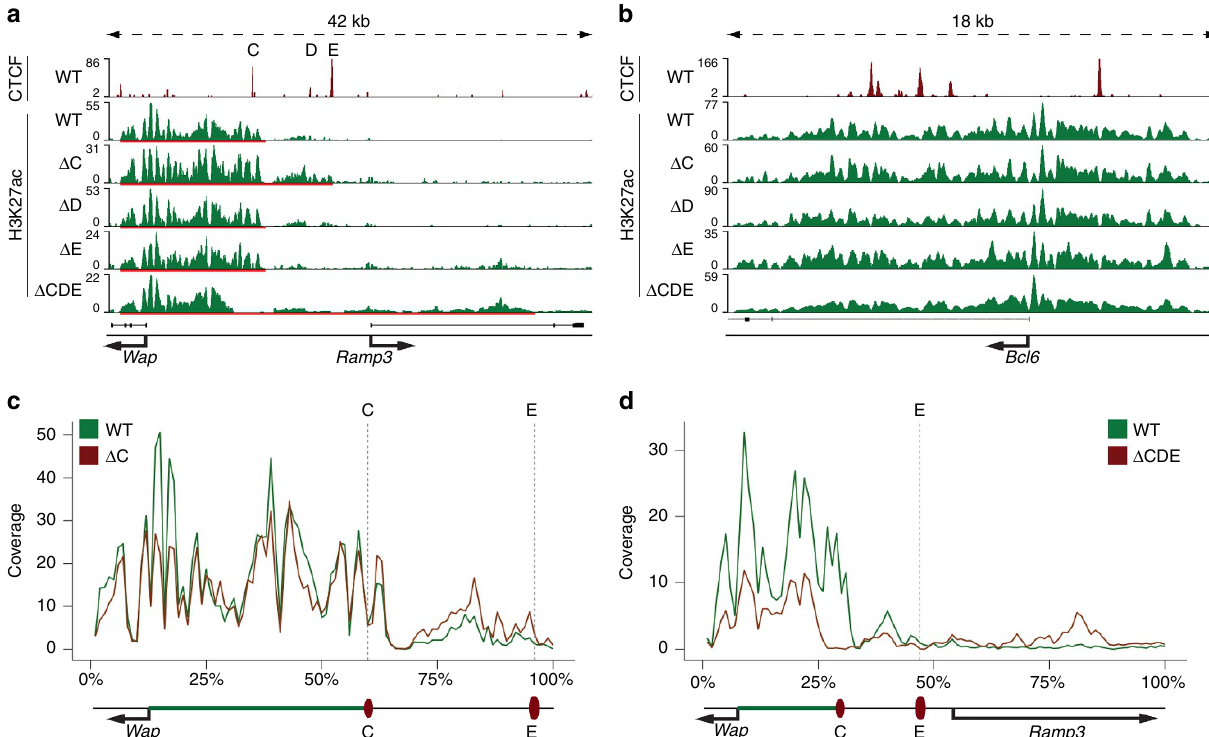
Figure 5 | Expansion of H3K27ac marks upon deletion of CTCF sites. ChIP-seq was used to identify changes of H3K27ac due to mutated CTCF-binding sites. ( a ) Deletion of CTCF site C resulted in the expansion of H3K27ac associated with the Wap super-enhancer (red bar). This was not observed upon loss of sites D or E. The combined loss of sites C, D and E resulted also in an expansion of H3K27ac and was particular strong at a specific site in the first intron of Ramp3 (normalized to 10 million reads) (red bar). ( b ) H3K27ac intensity was equivalent in the unrelated Bcl6 locus. ( c ) H3K27ac profiles of the Wap-Ramp3 locus based on the data shown in a . Green, WT pattern; red, D C. The degree of H3K27ac in mutants was elevated between CTCF sites C and E confirming the expansion of H3K27ac (normalized to 10 million reads). ( d ) H3K27ac profiles of the data shown in a . WT is shown in green, D CDE in red. H3K27ac marks spread from site E to the second exon of Ramp3 (normalized to 10 million